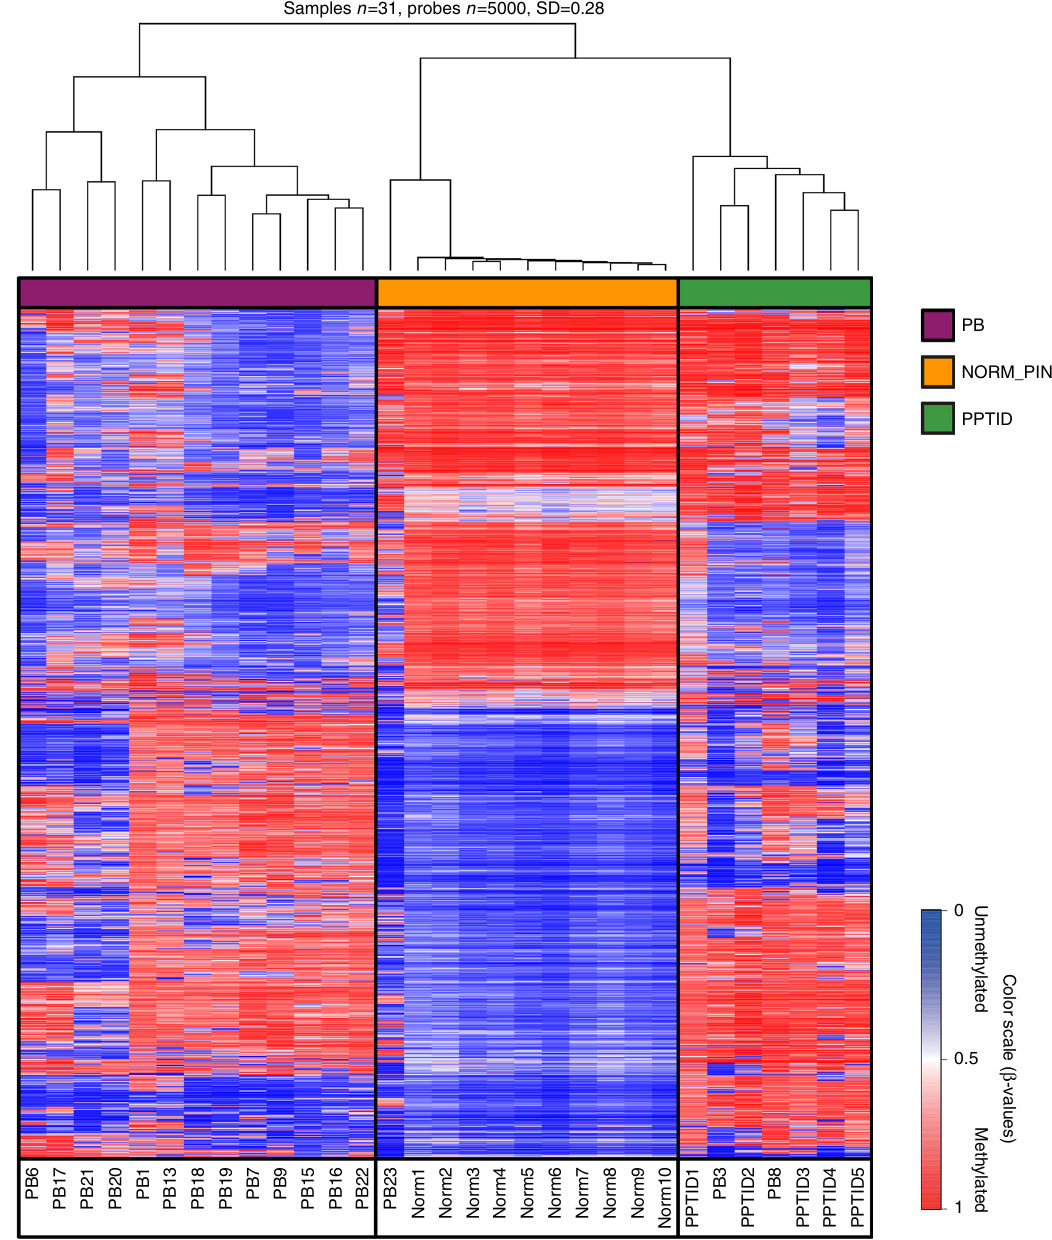
Fig. 1 Methylation signature of pineoblastoma, pineal gland, and PPTID. Pediatric pineoblastomas form a distinct cluster that is separated from normal pineal gland and pineal parenchymal tumor of intermediate differentiation (PPTID). However, adult pineoblastomas cluster with PPTID (PB3 and PB8) as well as the normal pineal gland group (PB23), although analyzed tissues were con fi rmed as pineoblastoma, suggesting that methylation signature re fl ects origin of adult pineoblastomas from a normal pineal gland or a lower grade precursor